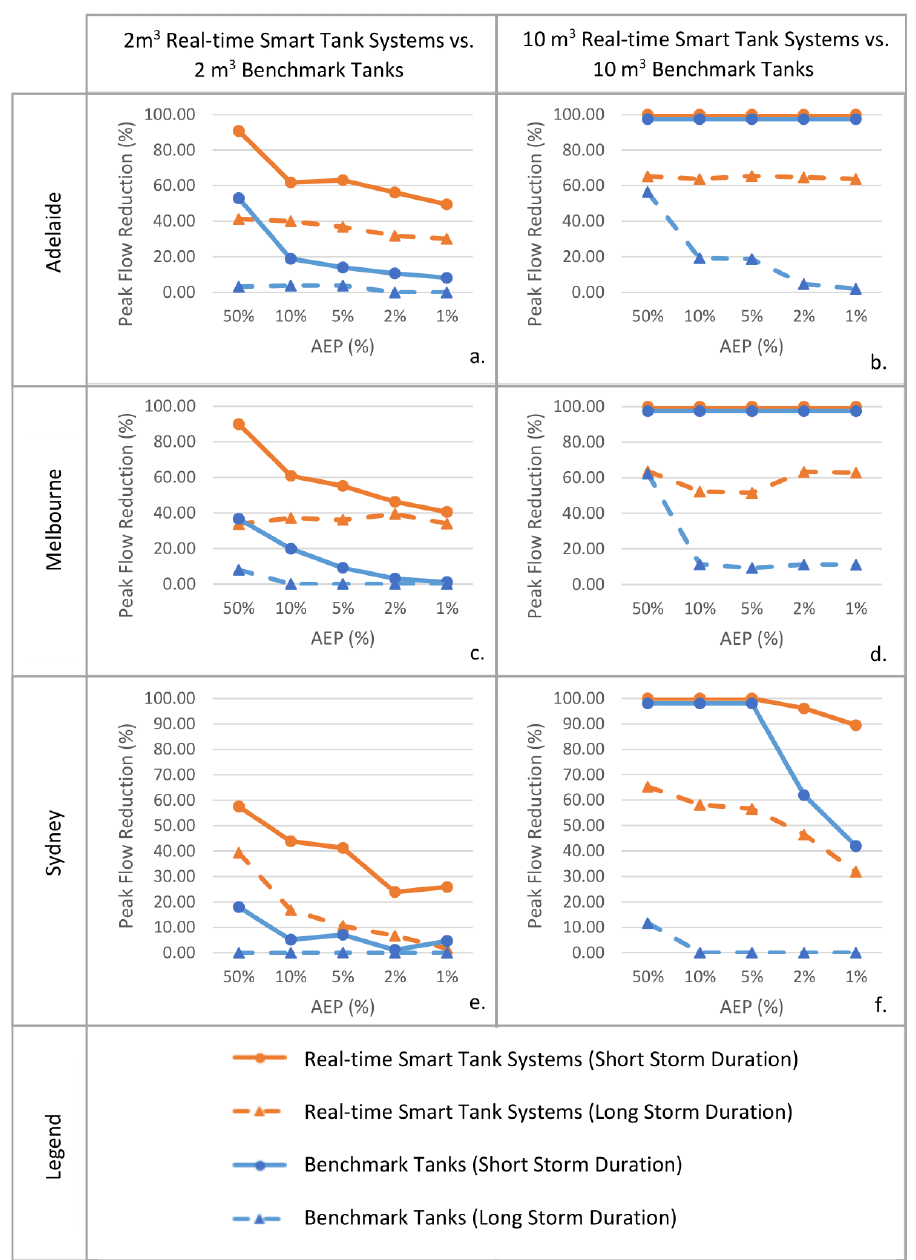
Figure 4. Performance of real-time, smart tank systems versus benchmark tanks for the three locations (Adelaide, Melbourne, and Sydney), two tank sizes (2 × 2 m 3 and 2 × 10 m 3 ), and five AEPs (50%, 10%, 5%, 2%, and 1%) considered. For the sake of clarity, only results for the shortest (30 min) and longest (24 h) durations considered are shown, with results for the full set of durations considered shown in Figure 5 and Appendix A. (A full dataset of peak flow reduction is available in Supplementary Materials File S1). The figure shows the performance of 2 m 3 real-time smart tank systems versus benchmark tanks for ( a ) Adelaide, ( c ) Melbourne ( e ). Sydney and 10 m 3 real-time smart tank systems versus benchmark tanks for ( b ). Adelaide, ( d ). Melbourne ( f )